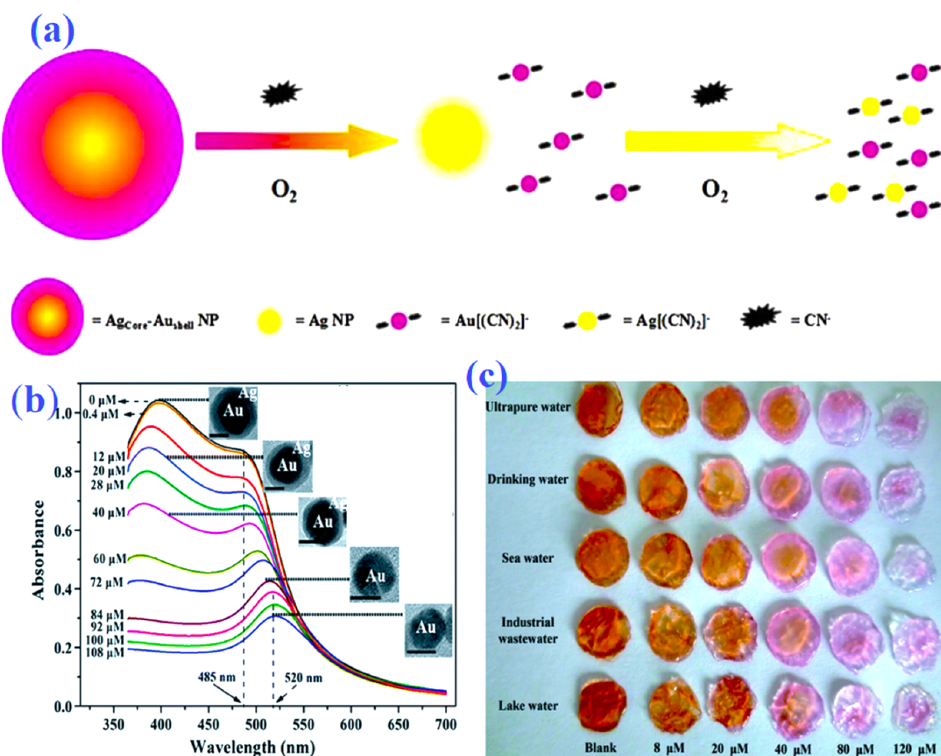
Figure 4. Schematic representation ( a ) for colorimetric detection of cyanide by Ag@Au core–shell NPs. Absorbance spectra ( b ) of the Au@Ag core/shell NPs with the increasing cyanide; the inset in ( b ) represents the corresponding HR–TEM images of the Au@Ag core/shell NPs treated with different amounts of cyanide. Agarose gel “test strips” ( c ) for the colorimetric detection of ultrapure, tap, sea, industrial, and lake water samples spiked with different concentrations of cyanide by Au@Ag core/shell NPs. ( a ) reproduced from Ref. [79] with permission from Elsevier. ( b , c ) reproduced from Ref. [83] with permission from the Royal Society of Chemistry.